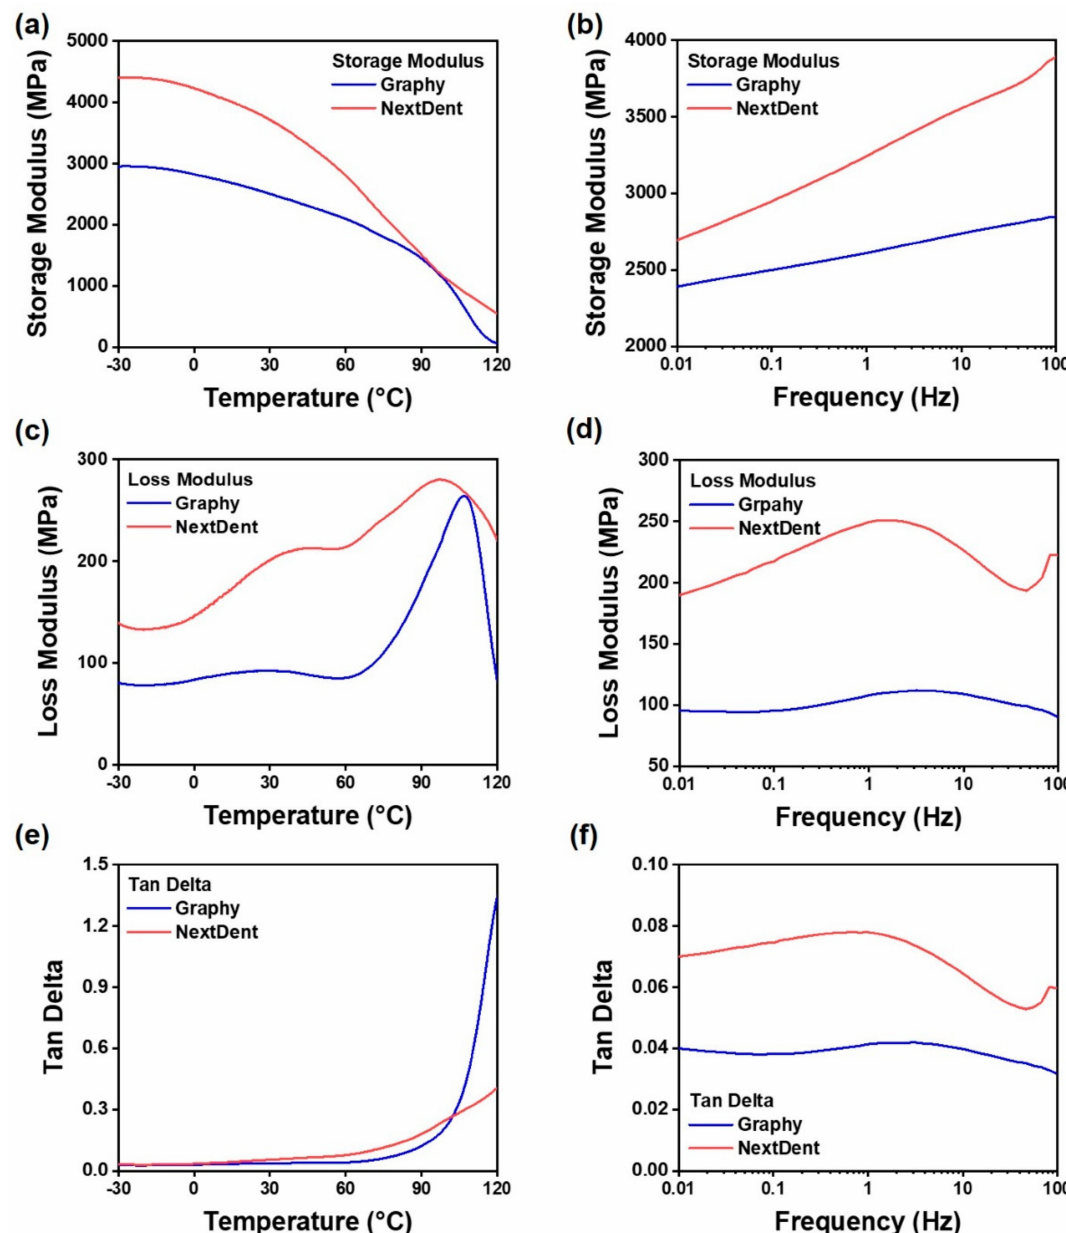
Figure 8. Illustration of dynamic mechanical property measurement results using temperature sweep and frequency sweep mode using DMA for 3D printing resins. In cases ( a – f ), measurements were performed using the dual cantilever mode of DMA, and the specimen size was output based on TA’s reference steel sample. ( a , c , e ) The range of − 30 to 120 ◦ C was measured under the conditions of 1 Hz and 0.1% using the temperature sweep mode of DMA. ( b , d , f ) The range of 0.01 to 100 Hz was measured under the conditions of 1 Hz and 0.1% using the frequency sweep mode of DMA. ( a , b ) The storage modulus of the materials is a graph. ( c , d ) Figures analyzing the loss modulus. ( e , f ) Graphs of the loss/storage modulus ratio (Tan delta) of the